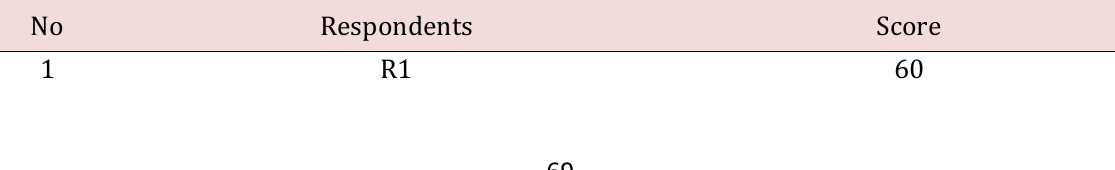
Table 2. Score of the students reading in cycle